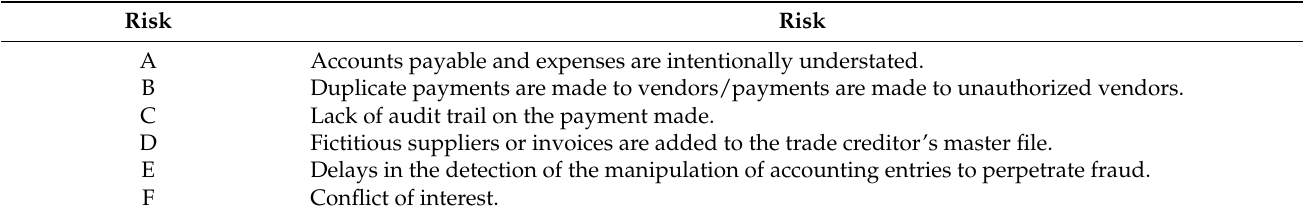
Table 1. Items for Fraud Risk Assessment.